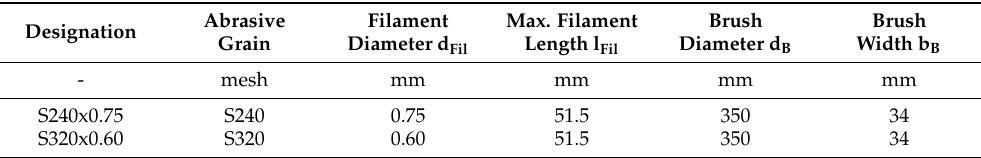
Table 4. Brushing process parameters. Brushing Infeed a eb